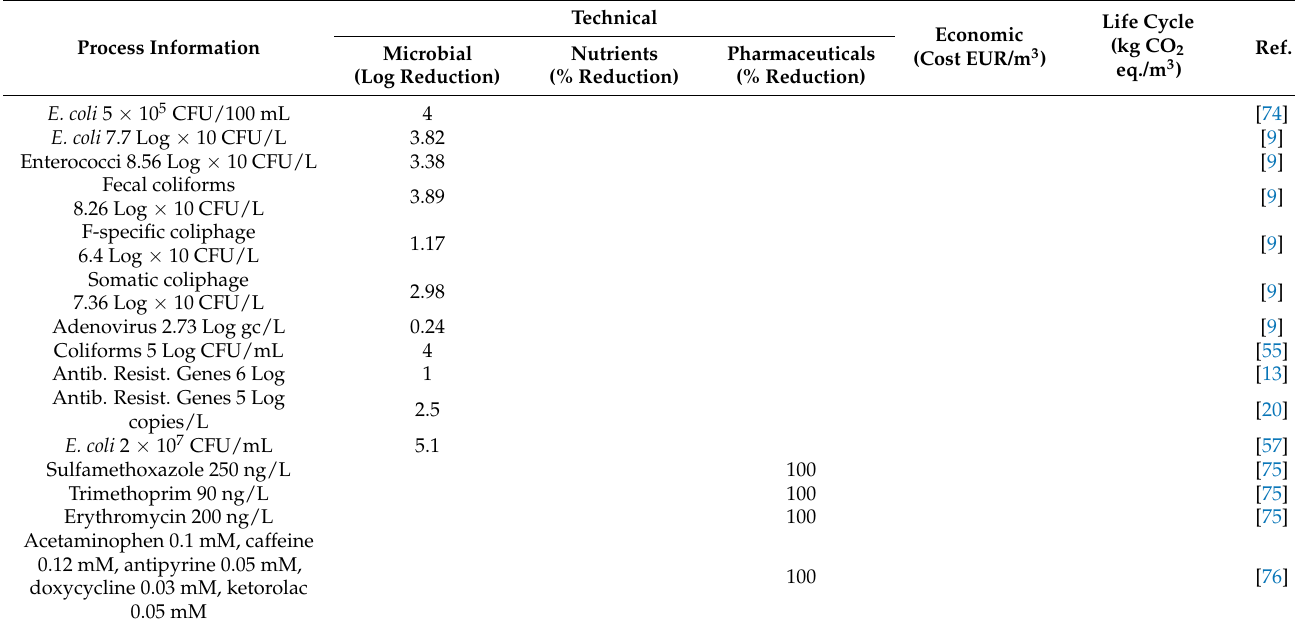
Table A2. Literature data used for scoring the UV